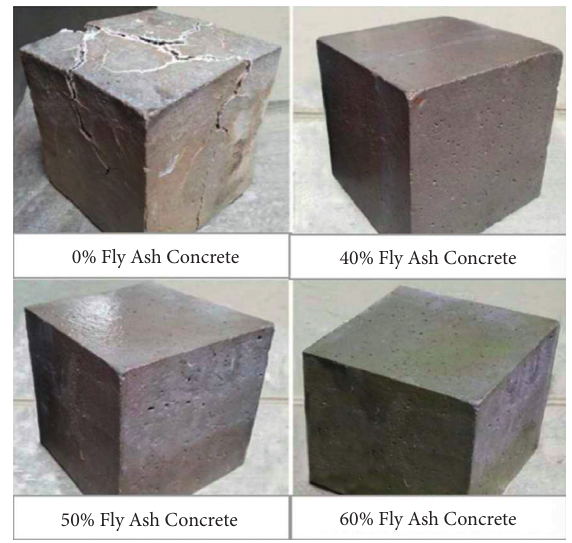
Figure 11: Concrete cubes after exposure to 10 wt.% sodium sulfate solution, reproduced from [90], a paper published in an open access